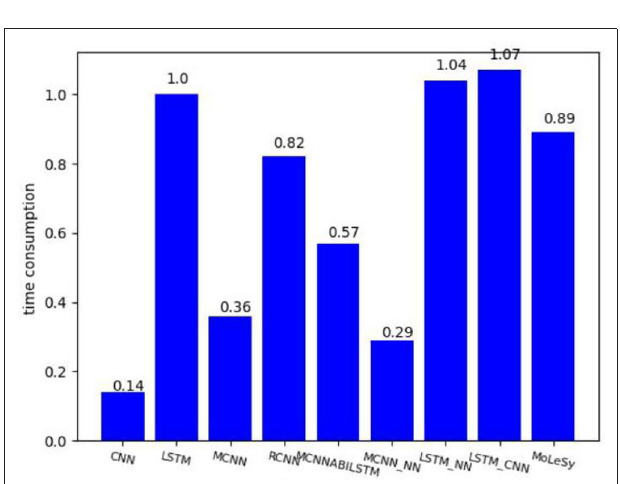
FIGURE 7 | The time consumption based on the LSTM